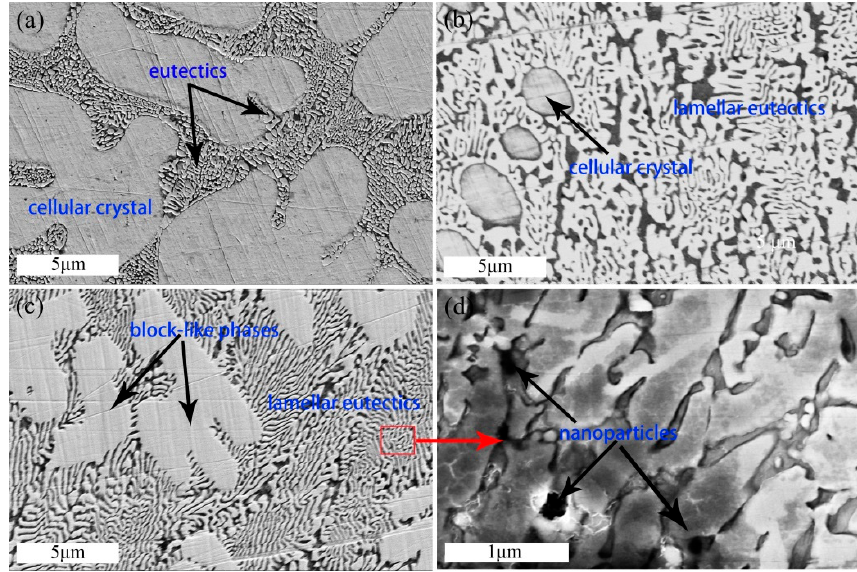
Figure 6. SEM micrographs of the different regions of Coating 1 and Coating 2: ( a ) middle region of Coating 1; ( b , c ) bottom region and top region of Coating 2; ( d ) high magnification of lamellar eutectics.